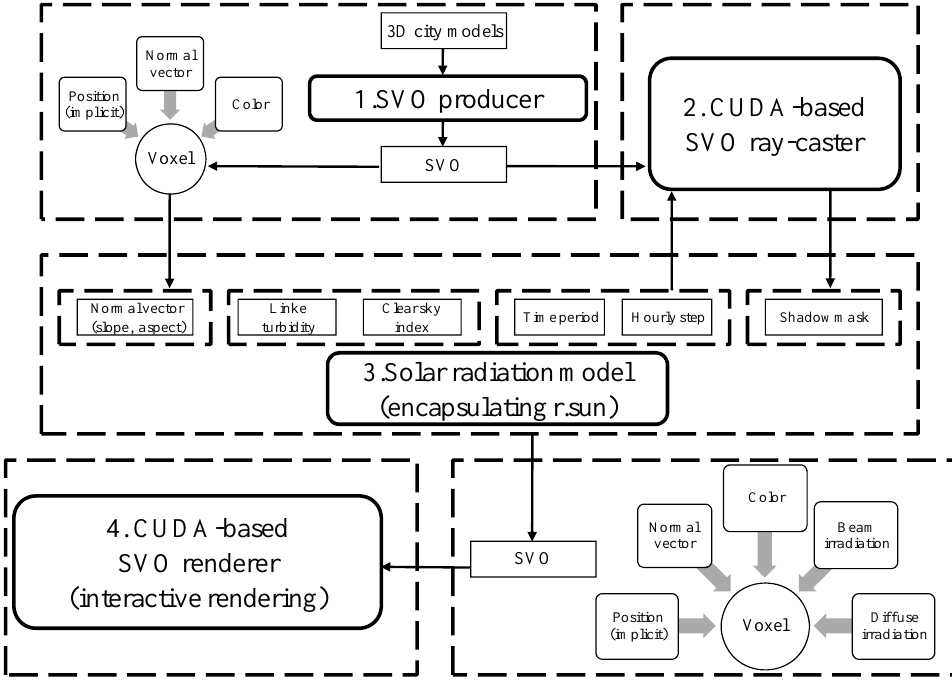
Figure 6. Proposed framework for SVO-based 3D solar radiation modeling.